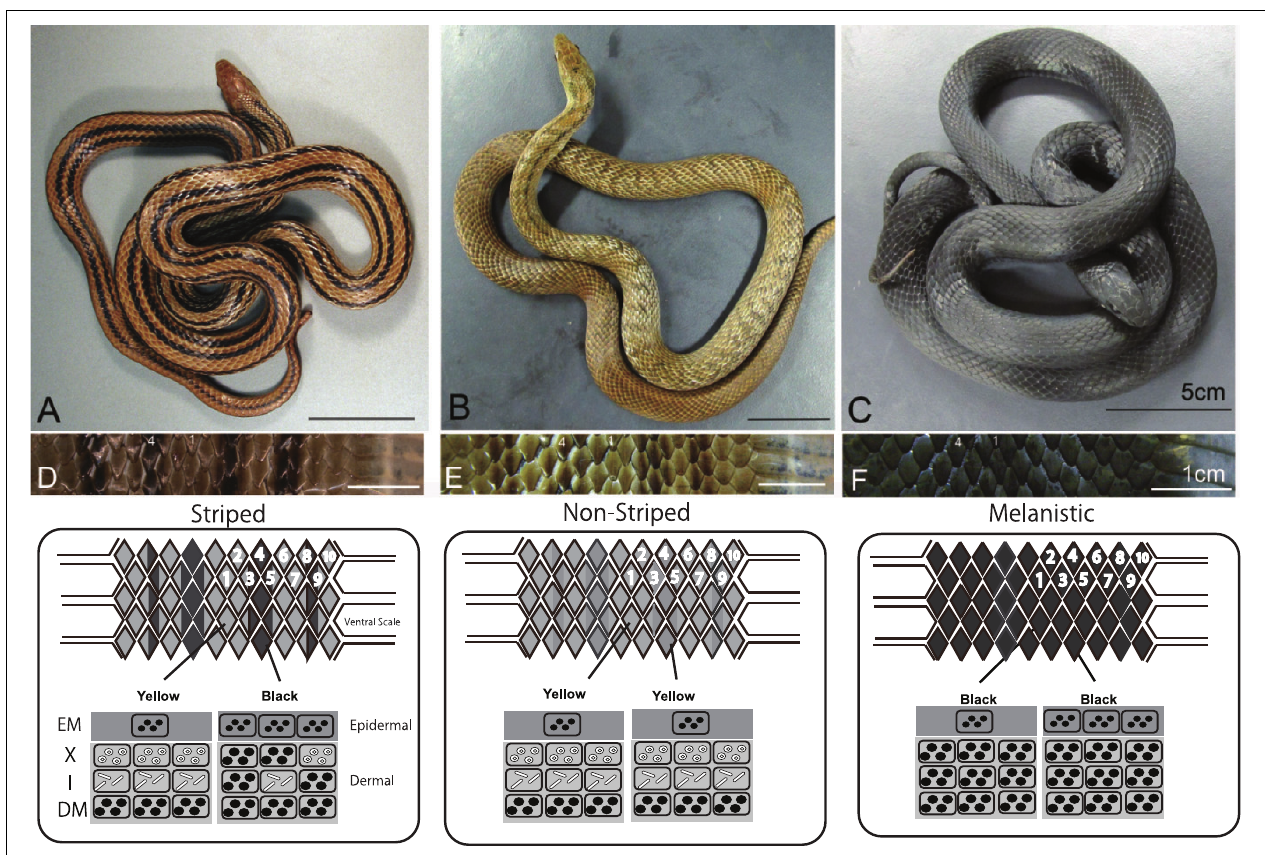
FIGURE 7 | Dorso-lateral views and vertical combination of pigment cells of three-color morphs of Elaphe quadrivirgata . (A) The striped morph with four vivid dark-brown longitudinal stripes over yellowish-brown back ground. (B) The non-striped morph with a uniform brown or light-brown ground color without a trace of the stripe pattern except the region just behind head. (C) The uniformly jet black melanistic morph with no sign of stripe pattern. (D) Magnified view of the dorsal surface of a striped morph. Two dorsal scales along the lateral direction were selected as standard landmark scales to describe stripedness (No. 1) and background coloration (No. 4). (E) Magnified view of the dorsal surface of a non-striped morph. (F) Magnified view of the dorsal surface of a melanistic morph. A schematic drawing of the vertical combination and relative thickness of epidermal and dermal pigment cells producing different skin coloration and color pattern in Elaphe quadrivirgata . Number, shape, and size of pigment cells and organelles are simplified and exaggerated. EM, epidermal melanophore; X, xanthophore; I, iridophore; DM, dermal melanophore. Figure from Kuriyama et al. (2013) with